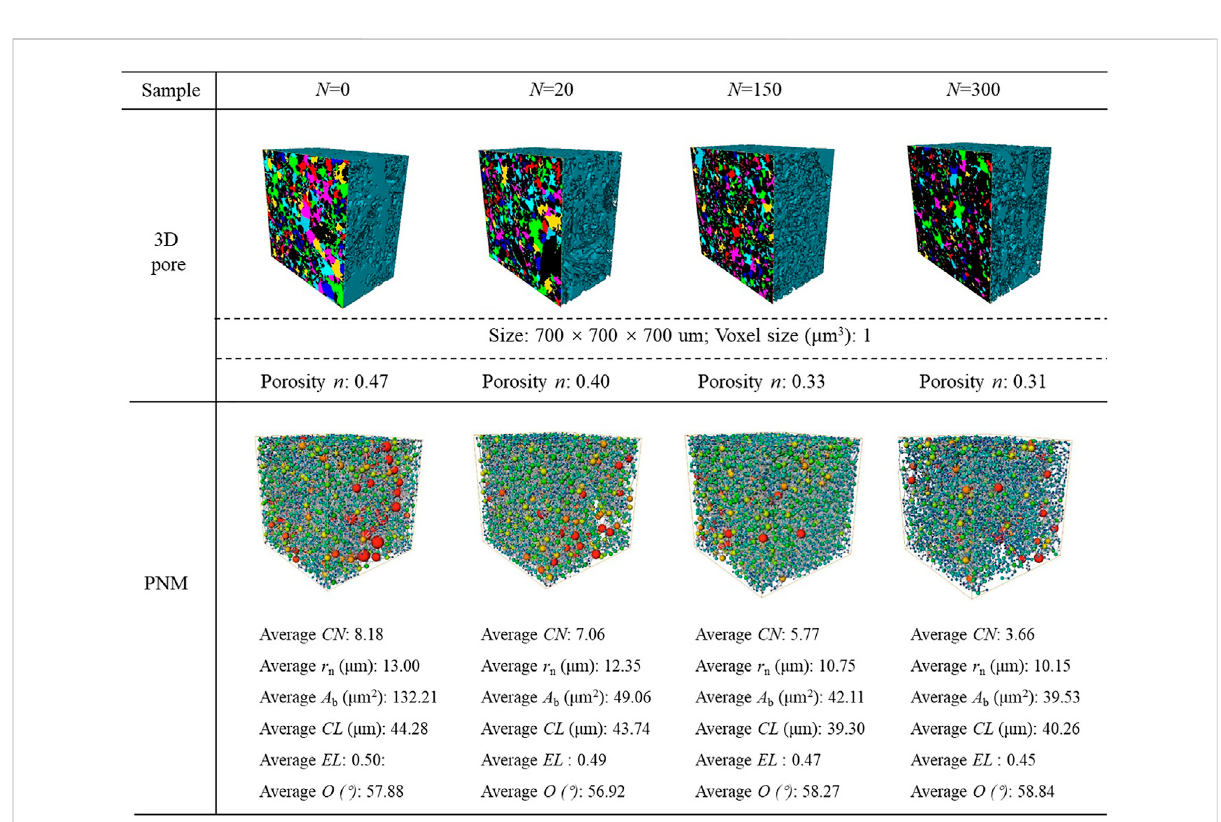
FIGURE 7 3D pore volumes and extracted PNMs with their